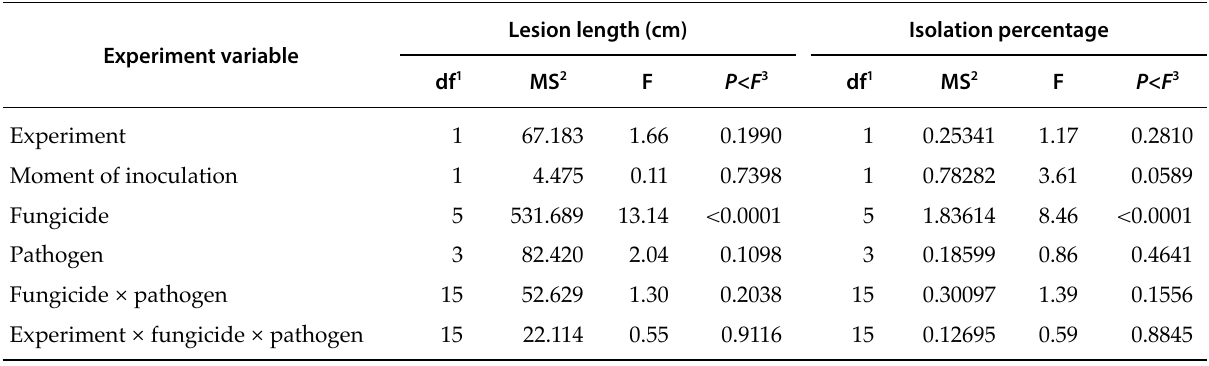
Table 3. Analysis of variance for effects of experiment, inoculation time, fungicide or pathogen, on lesion length and isola - tion percentage, resulting from inoculations with Diplodia seriata , Neofusicoccum luteum , N. mediterraneum or N. parvum on pruning wounds of almond trees cv. Ferragnes 5 months after pruning and fungicide application.